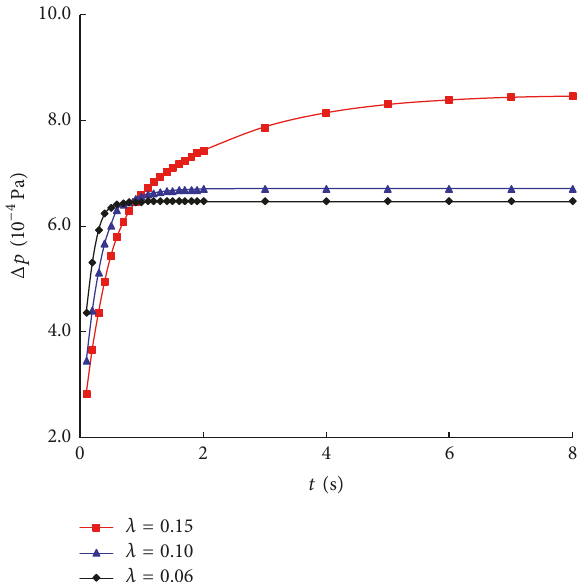
Figure 4: Pressure difference between inlet and outlet with different elastic polymer flow.